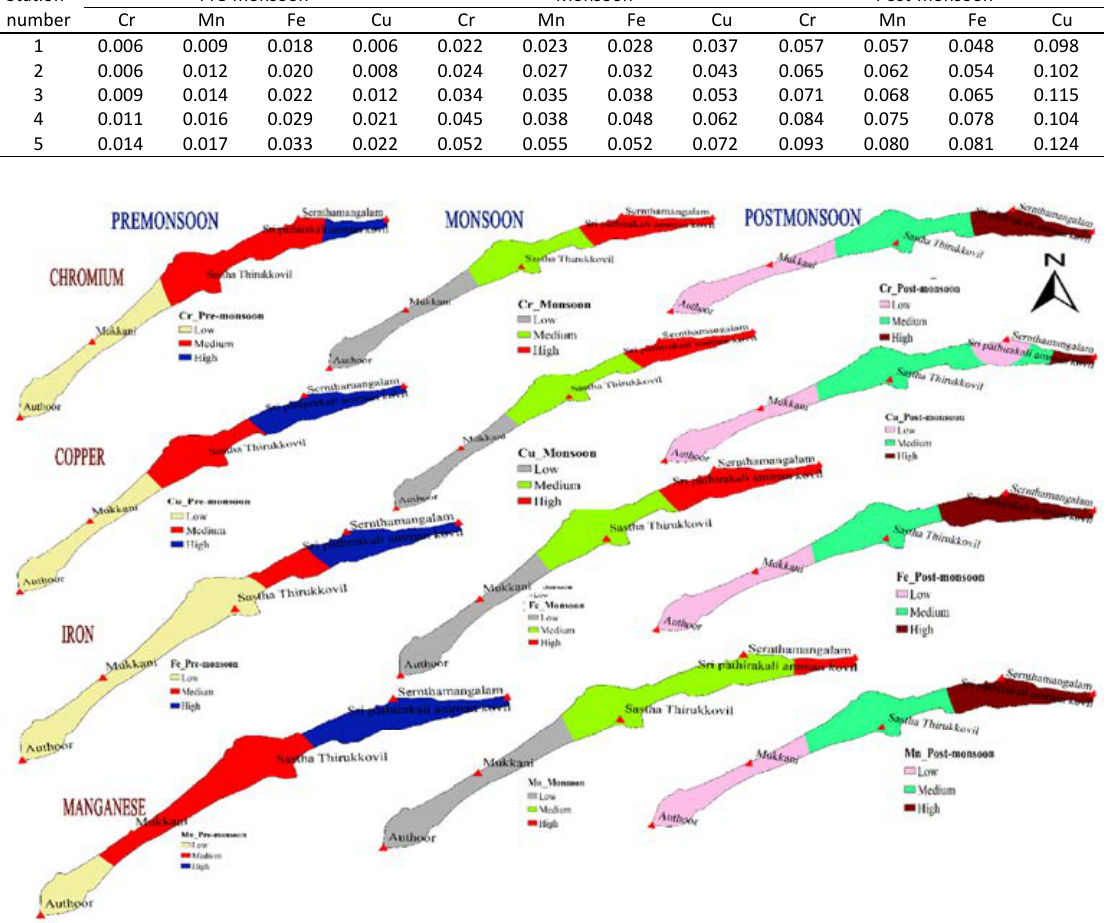
Fig. 4: Contamination factor of Cr, Cu, Fe, and Mn in